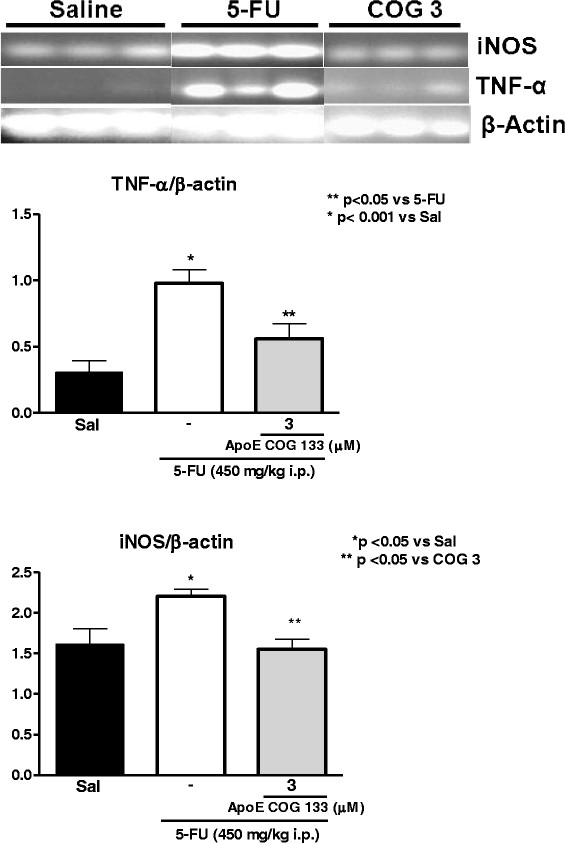
Reverse-transcriptase analyses on tumor necrosis factor-alpha (TNF-α) and inducible nitric oxide synthase (iNOS) mRNA transcripts in the proximal intestine (N = 4 for each group). Proximal intestinal segments were harvested from experimental mice on the fourth day. Densitometry results after normalized by β-actin are shown as mean ± SEM.